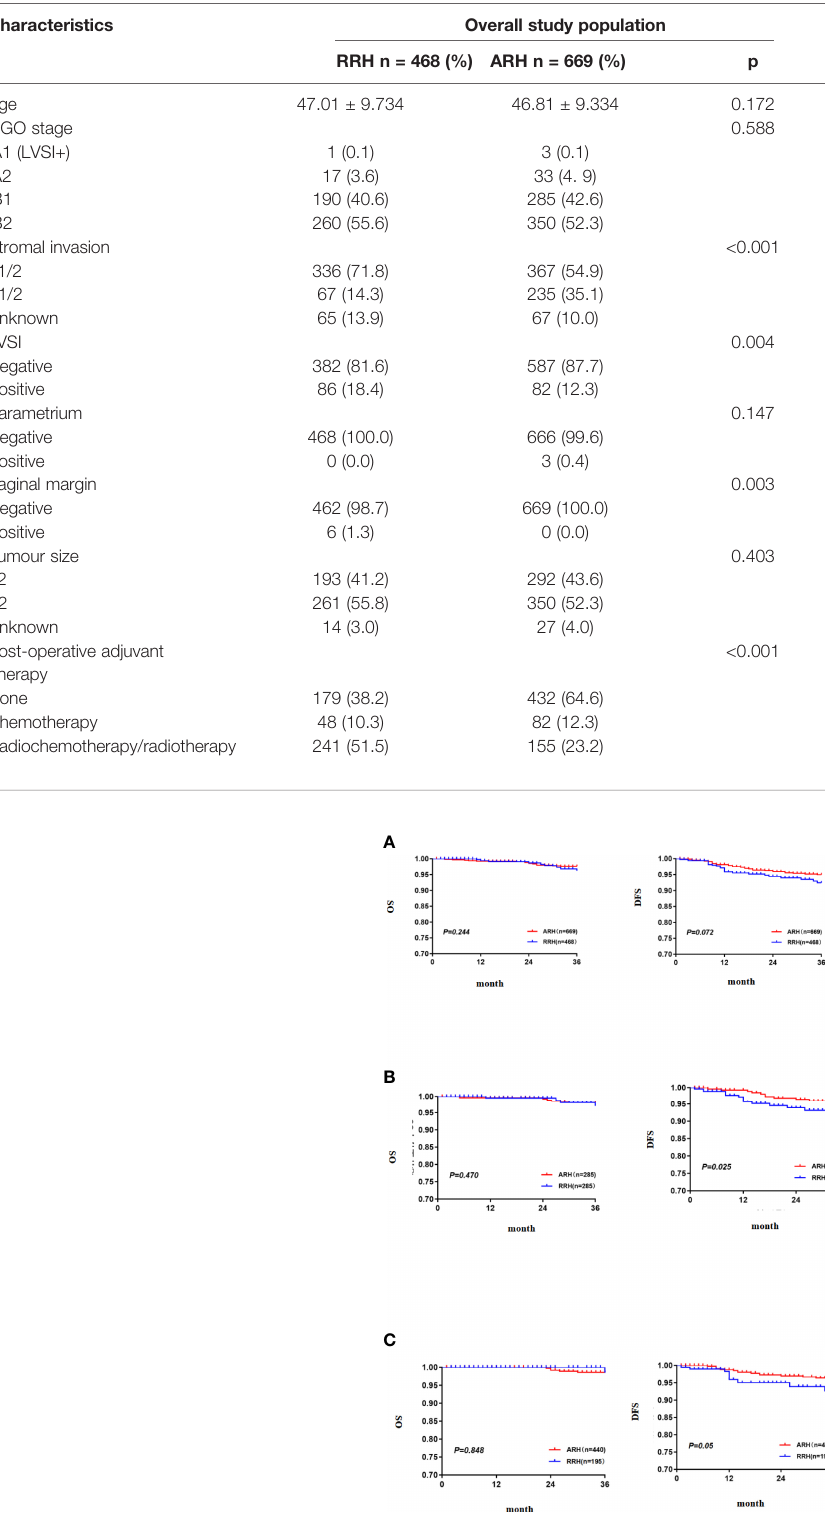
FIGURE 2 | The 3-year OS and DFS [ (A) the 3-year OS and DFS in the total study population, (B) the 3-year OS and DFS after PSM, (C) the 3-year OS and DFS in the subgroup of standard post-operative adjuvant